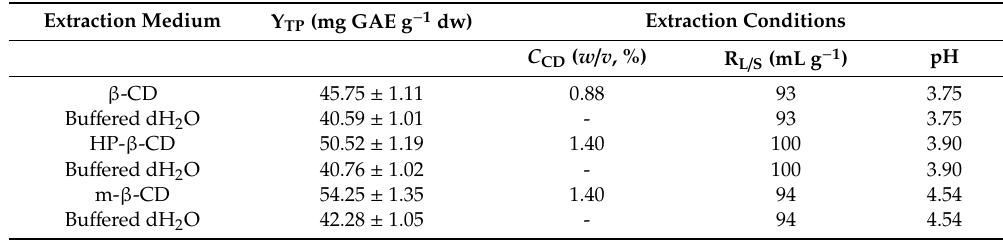
Table 6. The e ff ect of each of the CDs tested on the extractability of polyphenols from S. fruticosa , compared with equally bu ff ered deionized water, under optimal R L / S